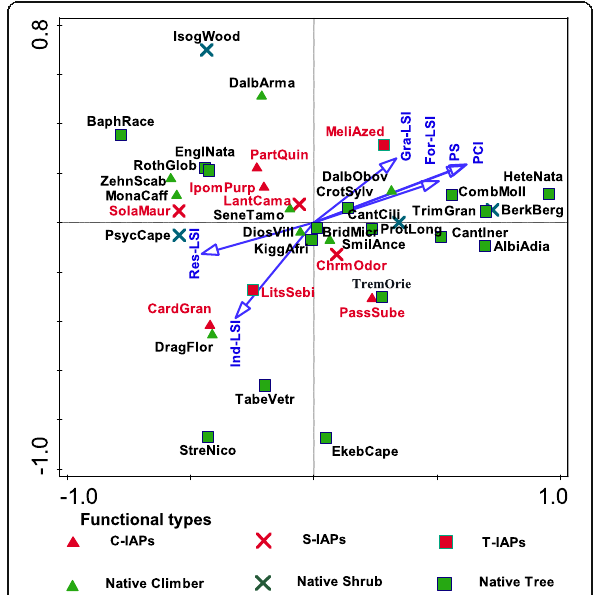
Fig. 6 The patch scale (broader-scale) spatial variables from the Durban Metropolitan Open Space System. Species codes are detailed in Table 3. Blue arrows and corresponding labels represent the environmental factors, while red labels are IAPs and black labels are native species